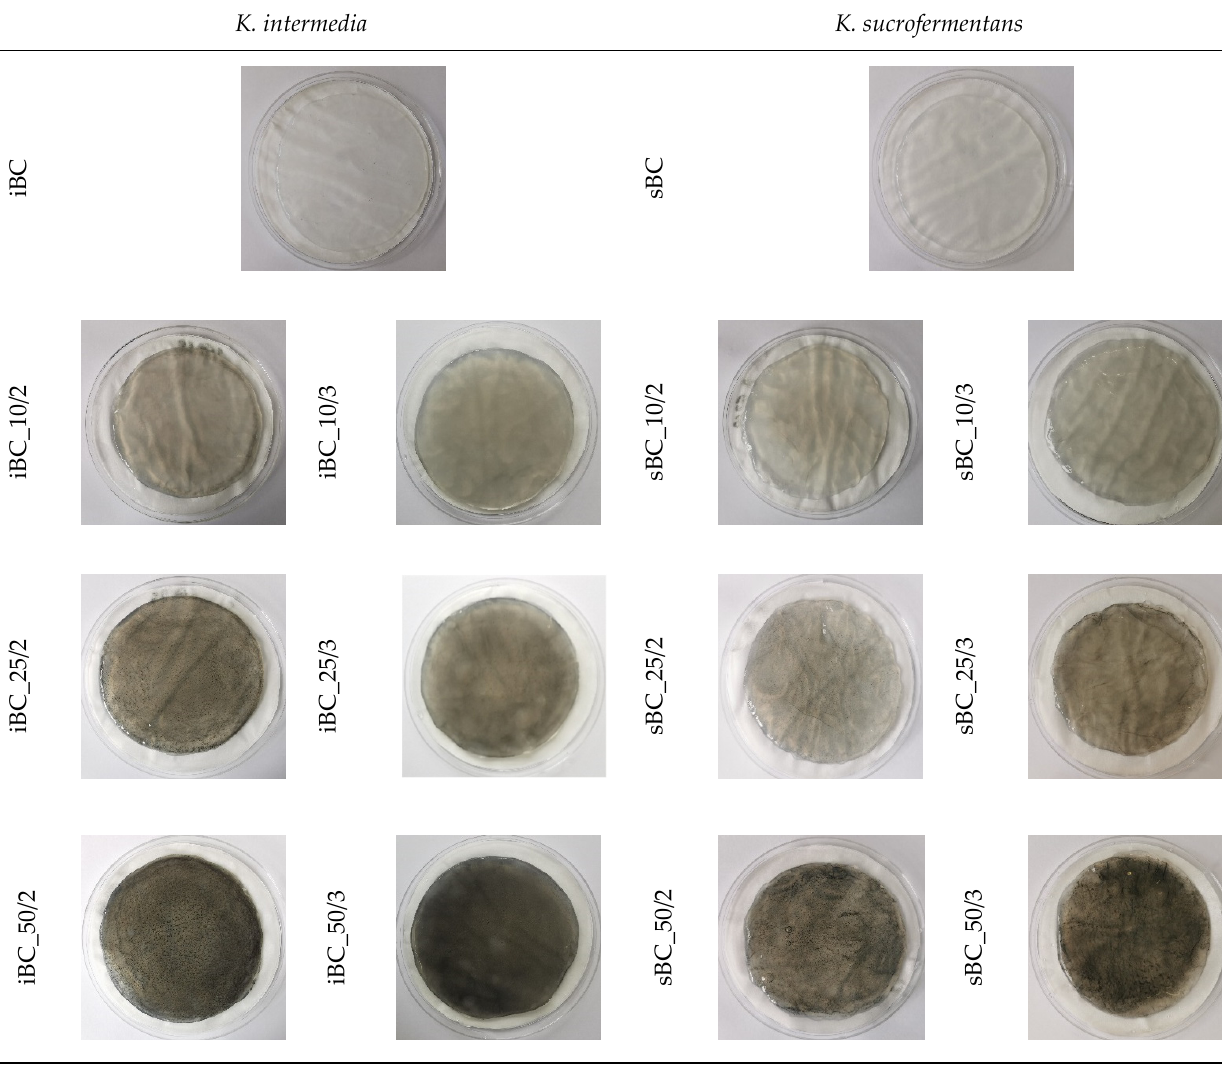
Figure 6. Photos of obtained pure BC and GO/BC